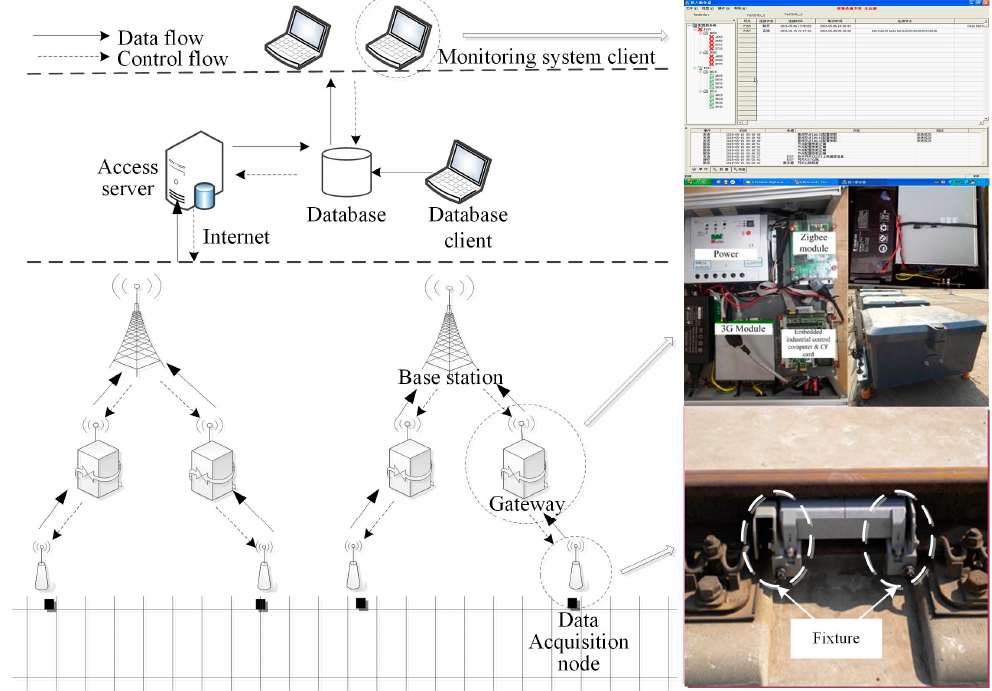
Figure 2. Architecture of the monitoring system.